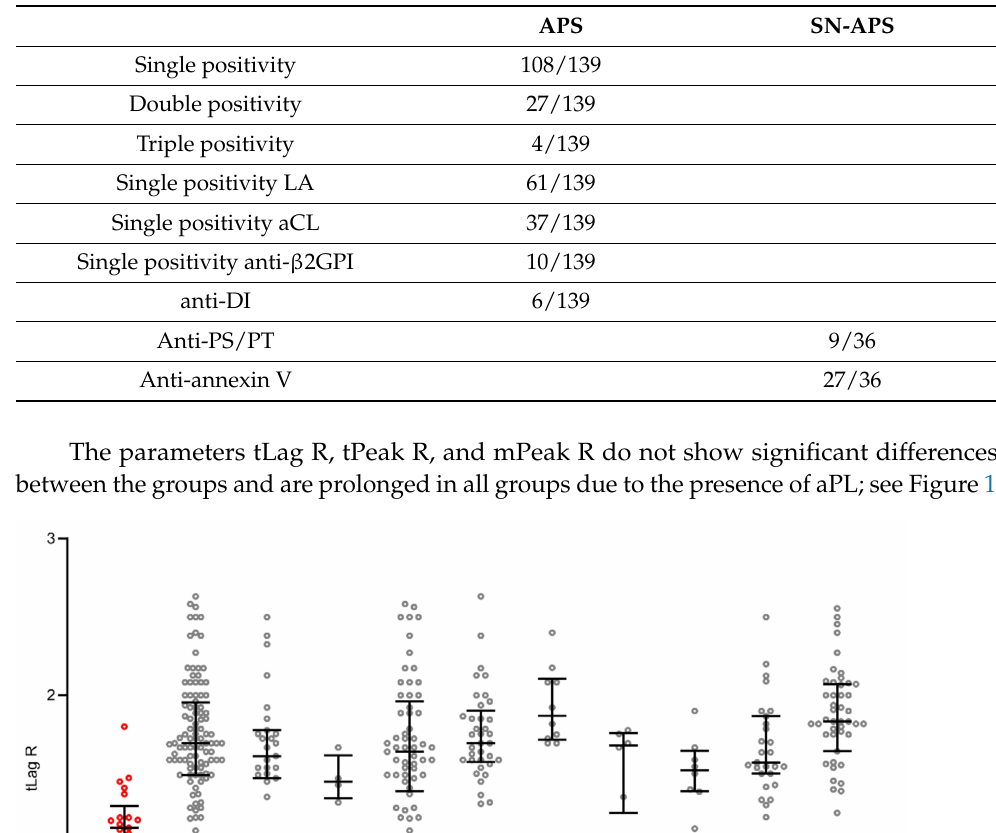
Table 2. Overview of biomarkers in the examined patient cohort. APS: antiphospholipid syndrome; SN-APS: seronegative antiphospholipid syndrome; LA: lupus anticoagulant; aCL: anti-anticardiolipin; anti- β 2GPI: anti-beta-2-glycoprotein I; anti-DI: anti-beta-2-glycoprotein I Domain I; anti-PS/PT: anti- phosphatidylserine/prothrombin.